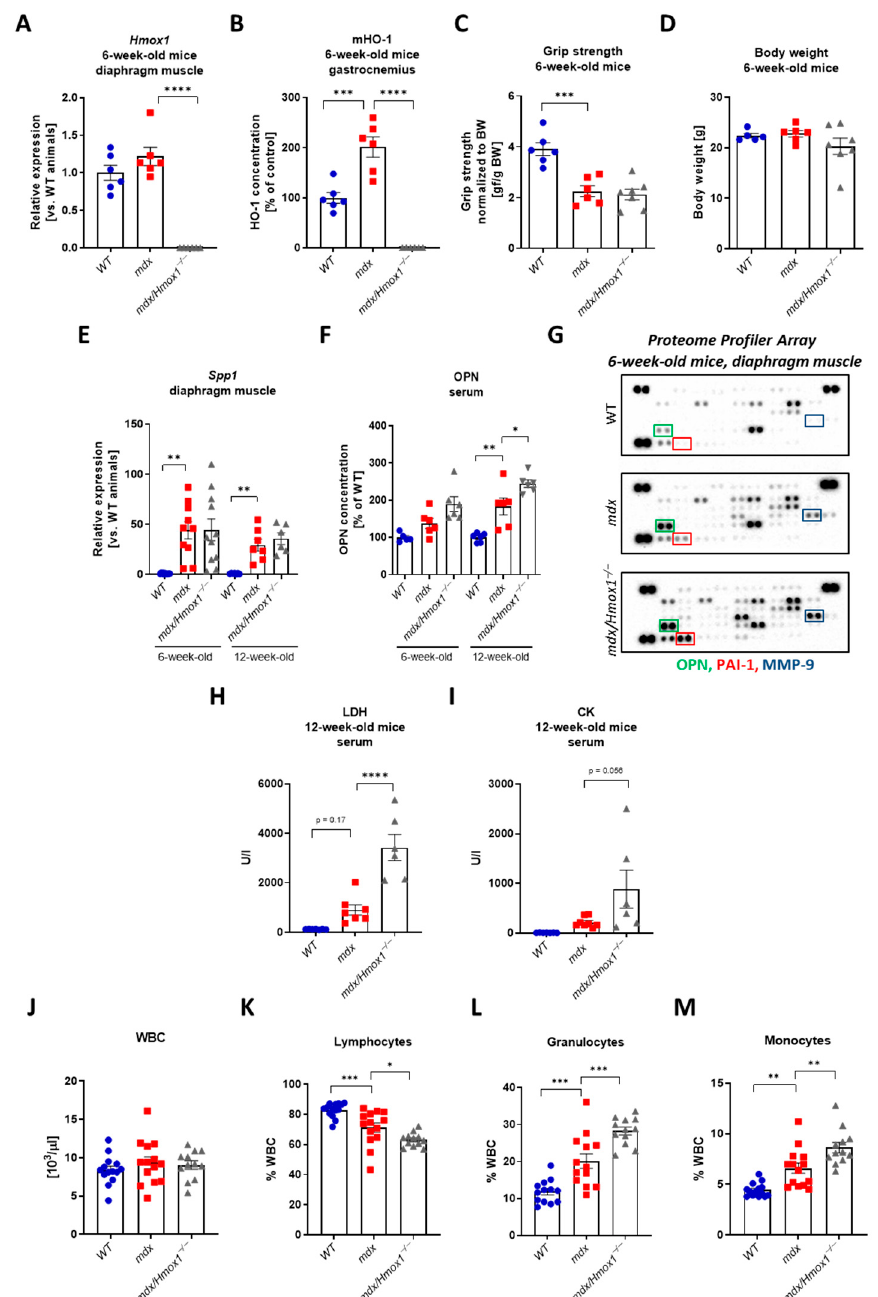
Figure 1. Validation of the animal model. Hmox1 expression in 6-week-old animals ( A ), qRT-PCR; n = 6/group. The protein level of HO-1 in gastrocnemius muscle ( B ), ELISA, n = 6. Dystrophic mice exhibit decreased muscular strength ( C ) , grip test, n = 6–7/group; and no difference in body weight ( D ), n = 5–7/group. The expression of DMD markers: Spp1 in the diaphragm ( E ) , qRT-PCR; n = 10–11/group and its protein level (osteopontin, OPN) in the serum of 6- and 12-week-old mice ( F ), ELISA; n = 5–6/group. The expression of OPN, matrix metalloproteinase-9 (MMP-9), and plasminogen activator inhibitor-1 (PAI-1) in the diaphragm of 6-week-old mice ( G ), Proteome Profiler™ array, representative results. Serum level of lactate dehydrogenase, LDH ( H ) and creatine kinase, CK ( I ) activity measured in 12-week-old mice; n = 6–8/group. The number of white blood cells (WBC) ( J ) and the percentage of lymphocytes ( K ), granulocytes ( L ), and monocytes ( M ); blood cell count, n = 12–14/group; Results presented as mean ± SEM. * p < 0.05, ** p < 0.01, *** p < 0.005, **** p < 0.0001 by one-way ANOVA with Tukey’s post hoc